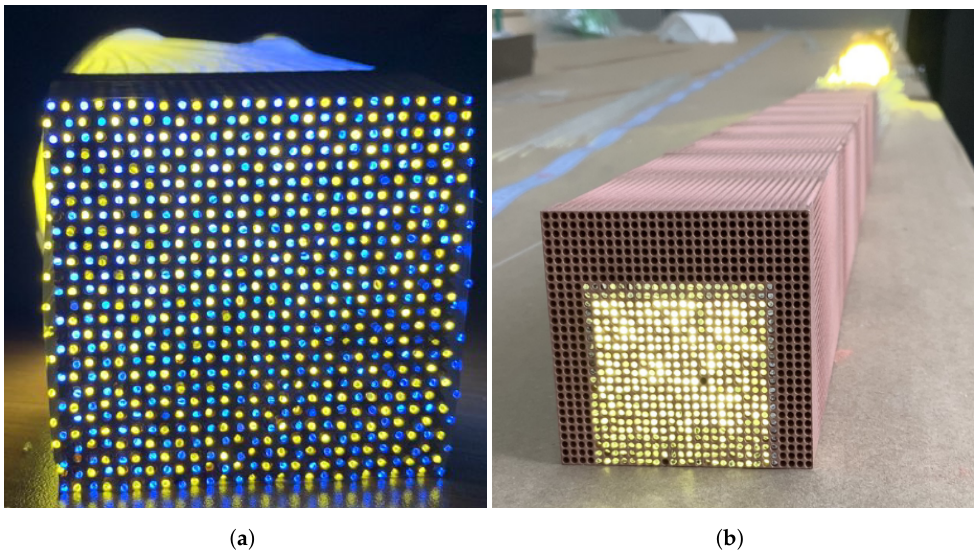
Figure 1. ( a ) Dual-readout calorimeter with Cherenkov fibers (blue light) and scintillation fibers (yellow light). ( b ) Projective geometry of dual-readout calorimeter with a copper absorber where only lit fibers on the rear side had full length that reached the front of the